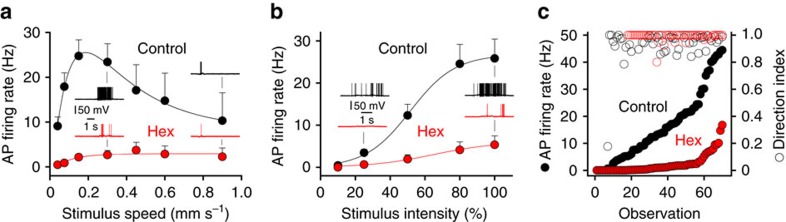
Cholinergic signalling controls the stimulus sensitivity and dynamic range of ON-DSGCs.(a,b) Antagonism of nAChRs (hexamethonium (Hex); red symbols and traces) attenuates action potential (AP) firing evoked by preferred direction light bars moved across the receptive field over a wide-range of speeds (a), and at the optimal speed across a range of light intensities (b; speed=0.24 mm/s). (c) Impact of cholinergic signalling on the computation of direction selectivity, and preferred direction light-evoked AP firing over the stimulus range shown in a,b. Note the decreased stimulus sensitivity, attenuation of AP firing rate, but preservation of directional tuning in hexamethonium. All light stimuli were applied under photopic conditions. Stimulus intensity is relative to background illumination.